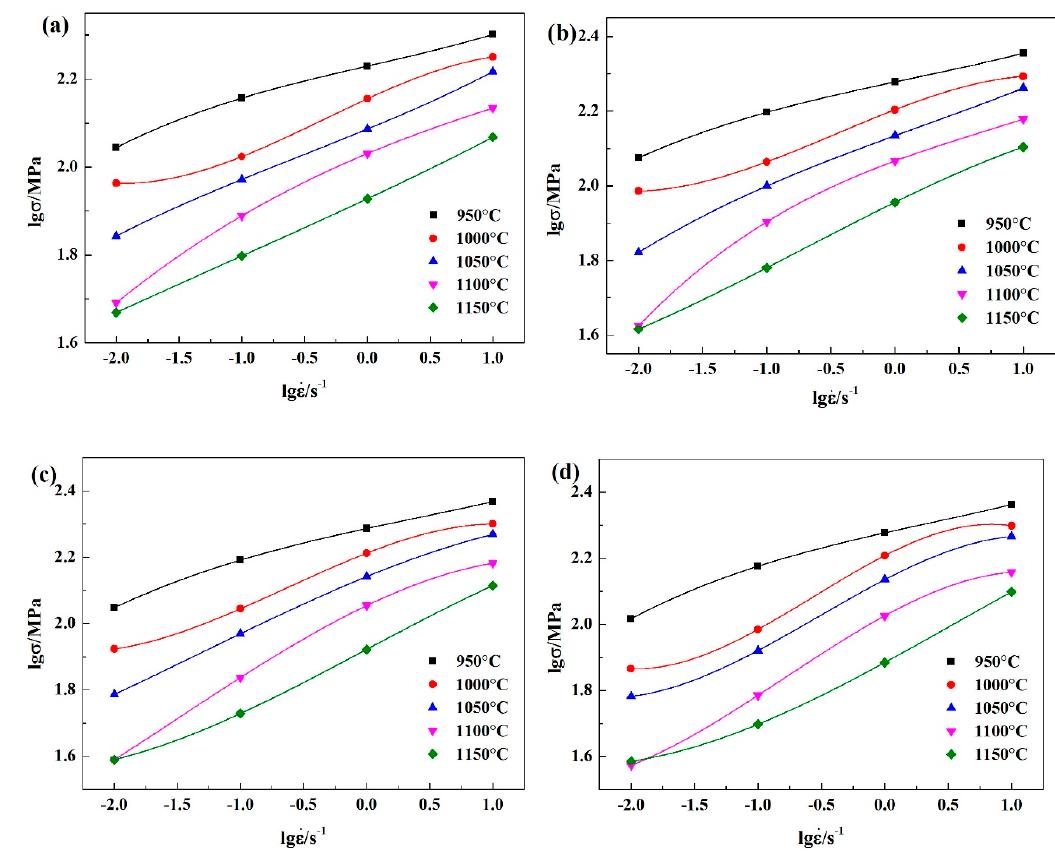
Figure 10. Variation of true stress with strain rate at different hot deformation temperatures when true strains are: ( a ) 0.2, ( b ) 0.4, ( c ) 0.6 and ( d ) 0.8.